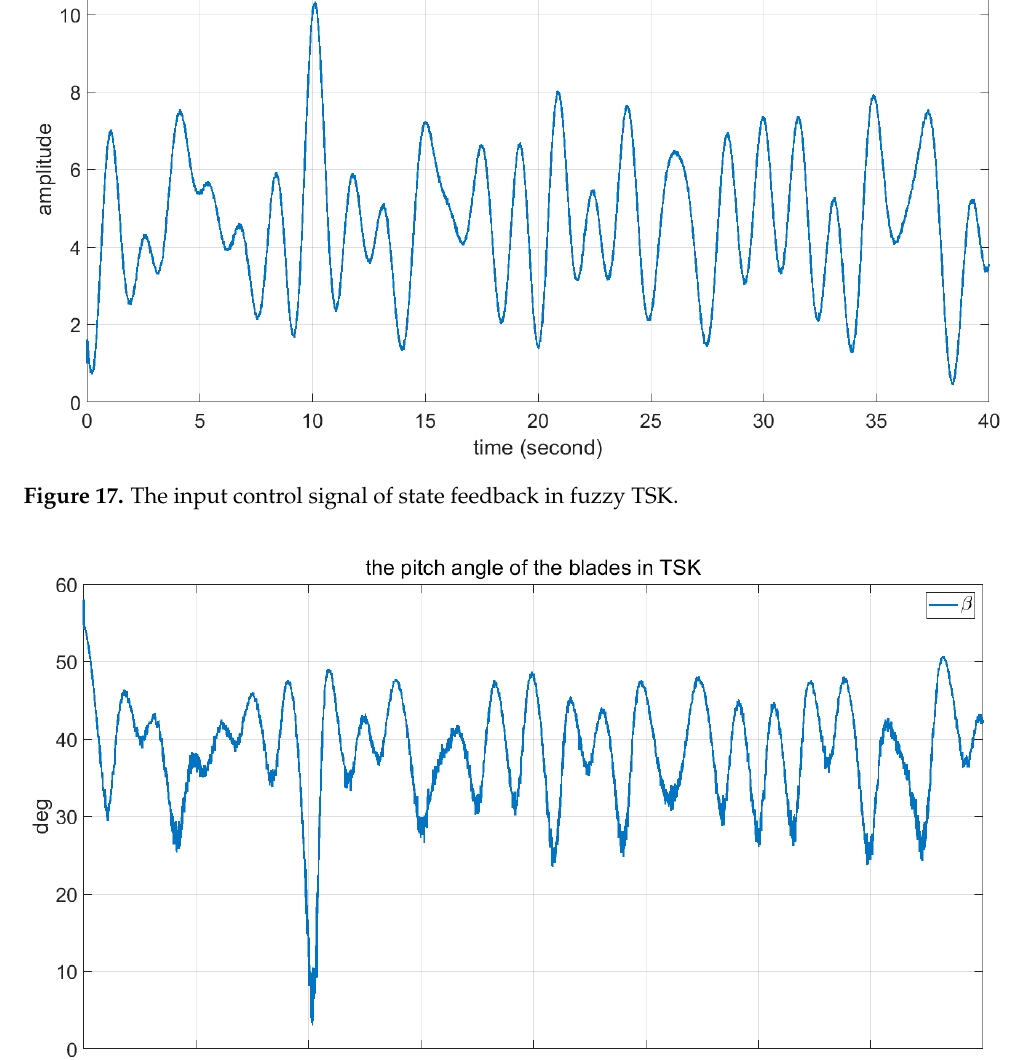
Figure 18. The angle of blades in fuzzy TSK.